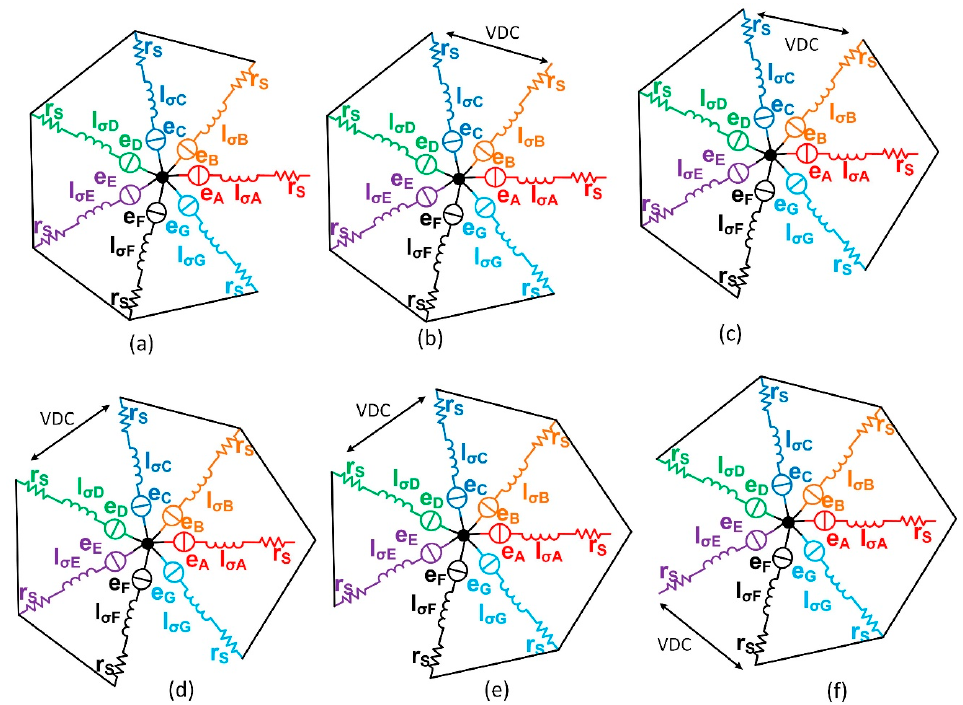
Figure 15. Dynamic equivalent of the seven ‐ phase PMSM after losing phase ‘A’ when active vectors: